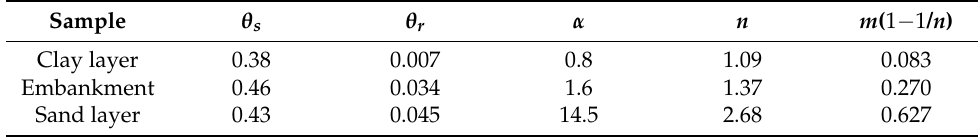
Table 4. Parameters of the soil–water characteristic curve used in the analysis.